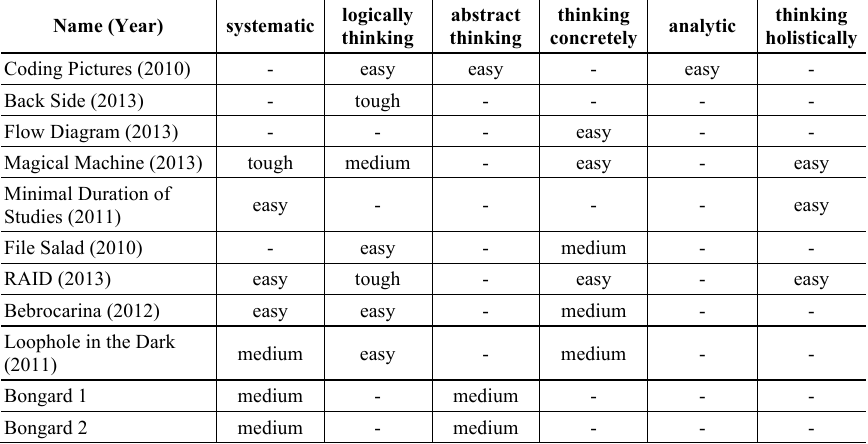
Table 6. Relating tasks and cognitive competences required for solving